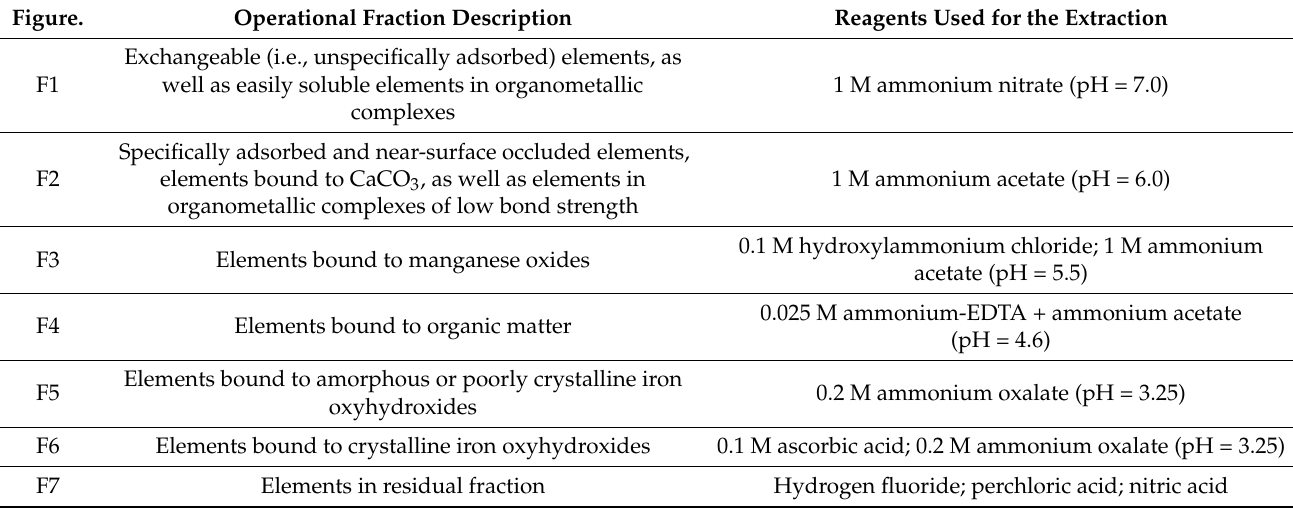
Table 2. Seven-stage sequential extraction procedure and description of operational fraction according to the Zeien and Brümmer method [71]. Figure. Operational Fraction Description Reagents Used for the